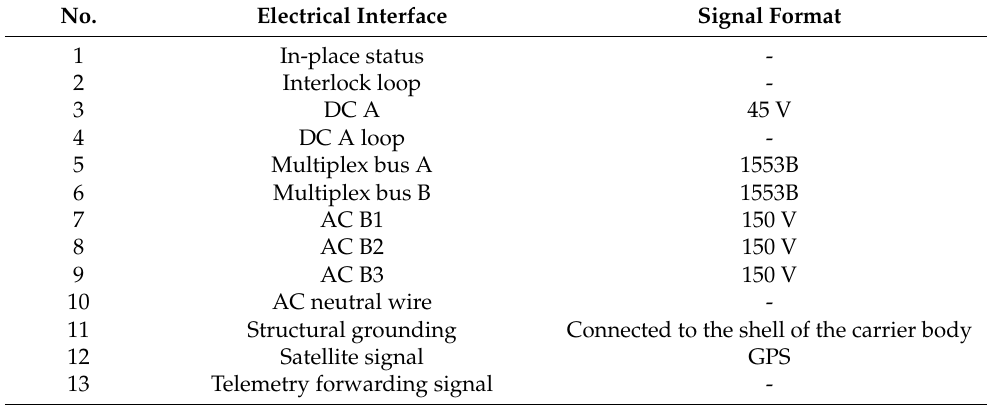
Table 7. Design of the electrical interface.